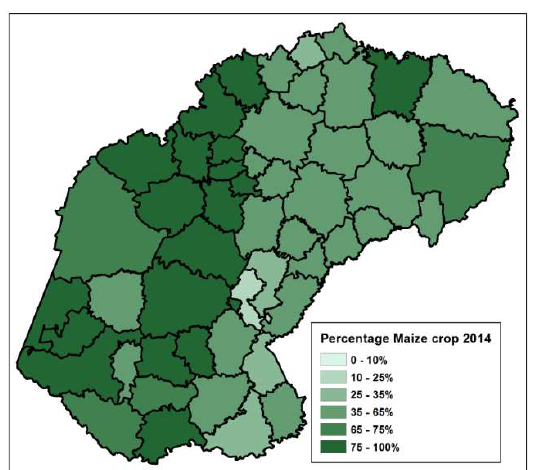
Figure 10. Calculated percentage of soybeans from other cultivated crops in 2014